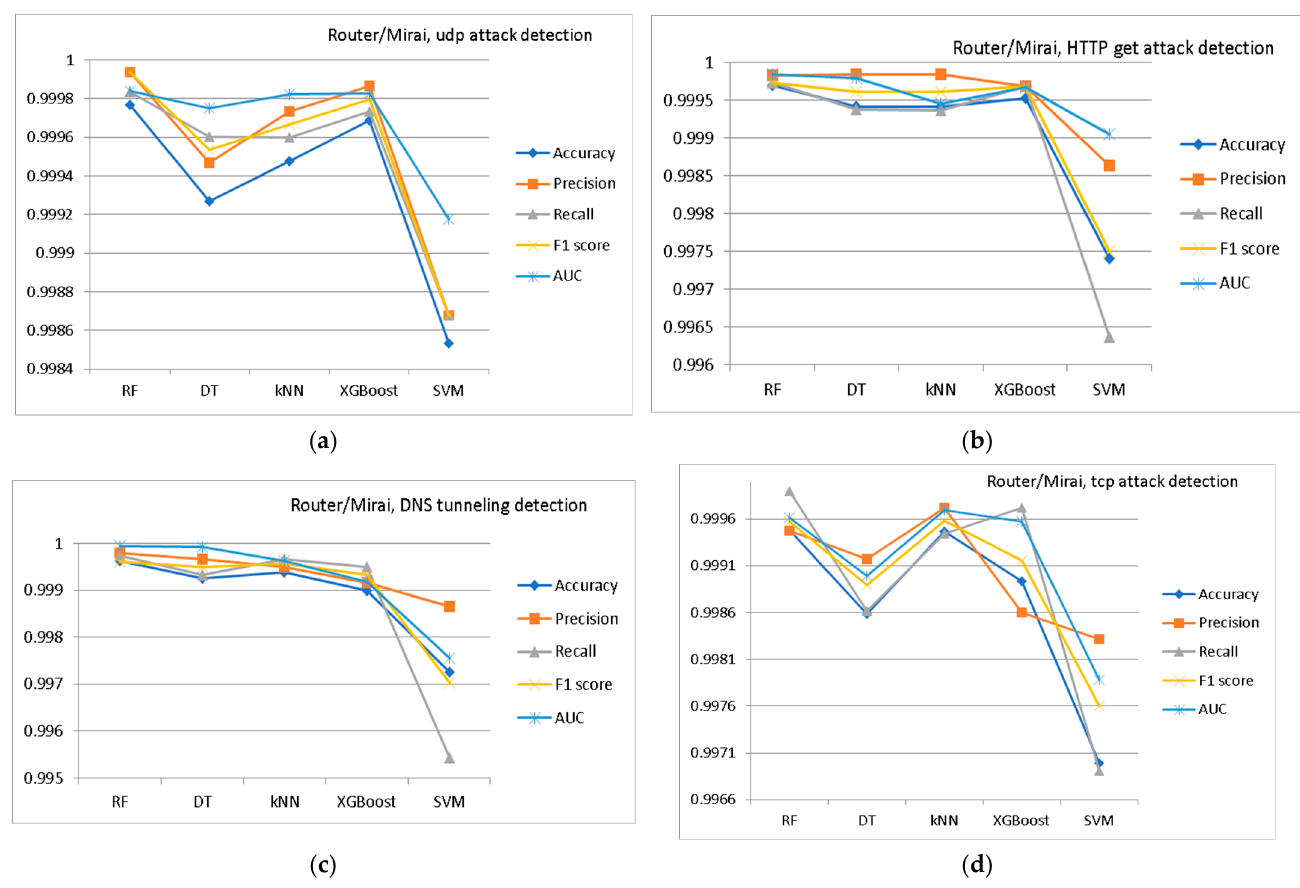
Figure 2. Comparison of different MLA efficiencies (decision tree—DT, random forest—RF, K- nearest neighbor—KNN, extreme gradient boosting—XGBoost, support vector machine—SVM) for Router/Mirai botnet detection: ( a ) TCP attack; ( b ) UDP attack; ( c ) HTTP GET attack; ( d ) DNS tunneling.